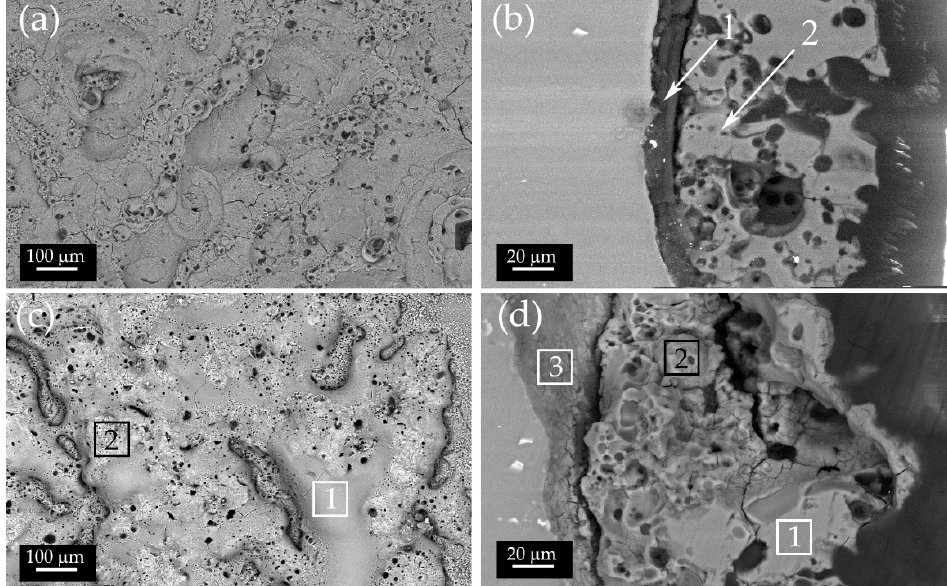
Figure 1. BSE ‐ scanning electron microscopy (SEM) images of: ( a ) surface and ( b ) the cross section of the Plasma electrolytic oxidation (PEO) treated sample; ( c ) surface and ( d ) the cross section of the PEO-BIO treated sample. The arrows in ( b ) highlight the zones where Energy Dispersive X ‐ ray Spectroscopy (EDS) analysis was performed in the cross section, whereas in ( a ) the analysis was performed on the whole surface. In ( c ), EDS analysis was performed on the whole surface and in the highlighted boxes, and in ( d ) this was performed in the highlighted boxes. Images of the surfaces were taken at 600×, whereas the ones of the cross section are at 1500×.